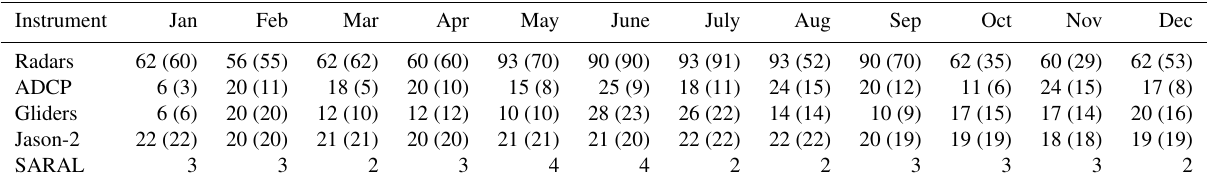
Table 2. Number of data samples per month for each current dataset during the period 1 January 2010–31 December 2016. The number of data selected for the climatology computation is indicated in